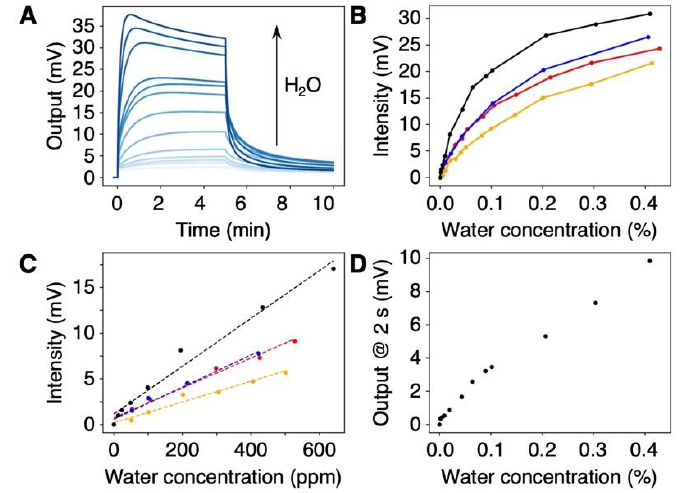
Figure 4. Quantification of trace amounts of water in various organic solvents. ( A ) Concentration- dependent signal responses to water in THF. The signal responses to other solvents are summarized in Figure S5. ( B , C ) Plots of signal intensities as a function of water concentration in the ranges of 0 – 0.4% ( B ) and 0 – 600 ppm ( C ) with different organic solvents: THF (black); acetone (red); acetonitrile (blue); and pyridine (orange). ( D ) Plot of signal output to THF, 2 s after injection.